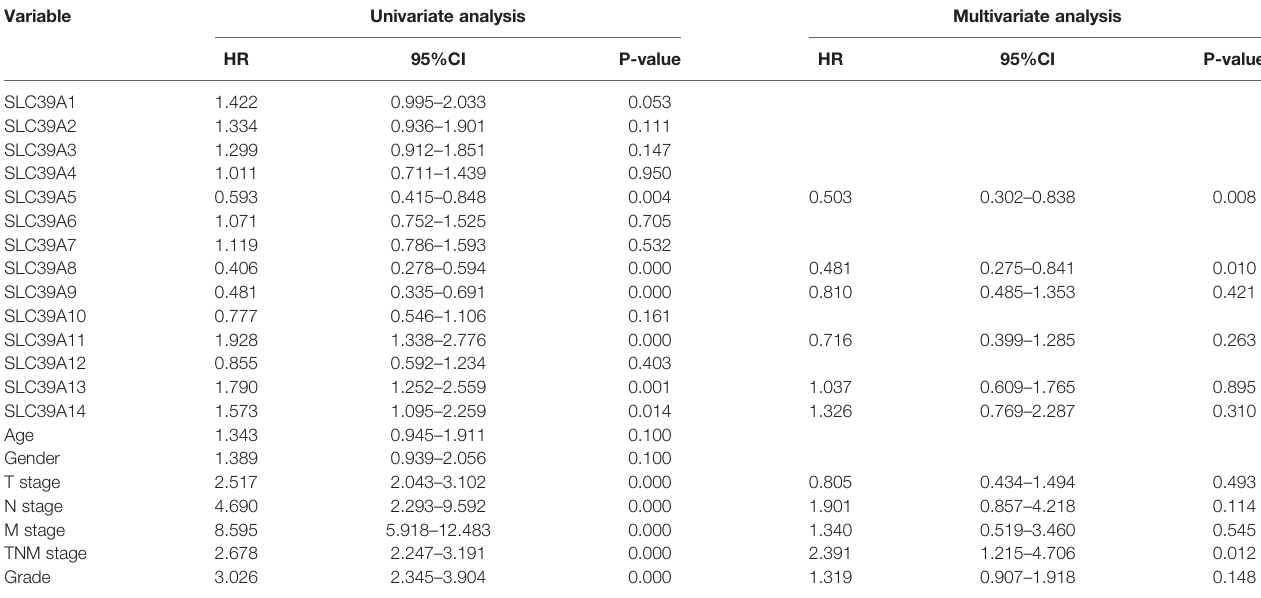
TABLE 2 | Univariate and multivariate analyses of ZIP family genes mRNA level and patient disease-free survival.